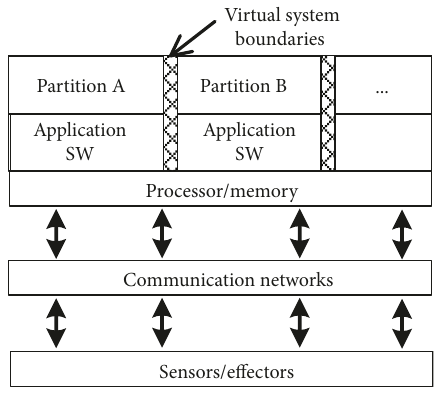
Figure 1: Model of the IMA system. Table 1: CPIOMs in the